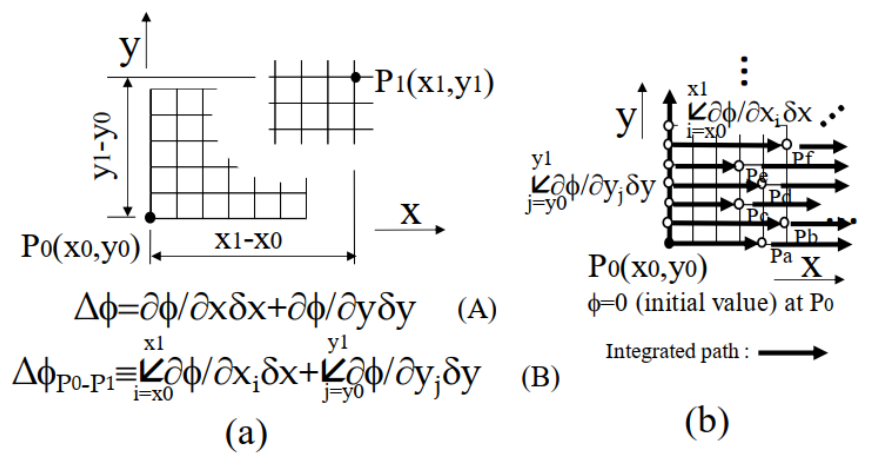
Figure 8. Integrating path in two-dimensional analysis. ( a ) Principle of producing integrating path for two-dimensional analysis; ( b ) Integrating path of analysis.